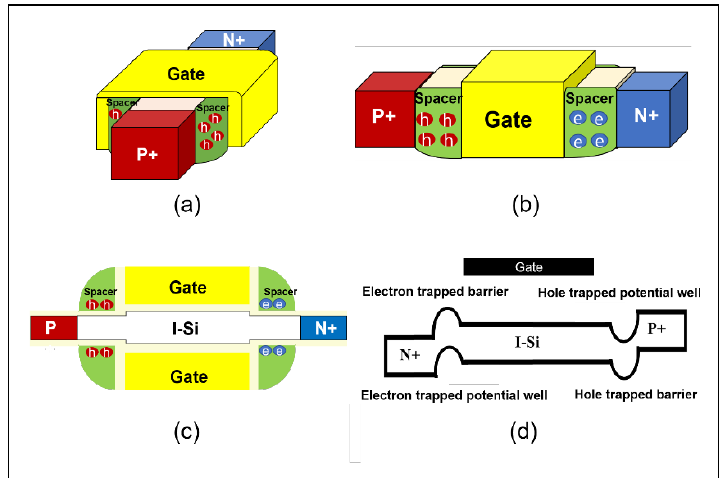
Figure 1. ( a , b ) Illustrated device structure of a P-I-N feedback field-effect transistor (FBFET) with trap- charged spacers, ( c ) its cross-sectional view along the channel direction, and ( d ) the corresponding energy band diagram for the FBFET [63].